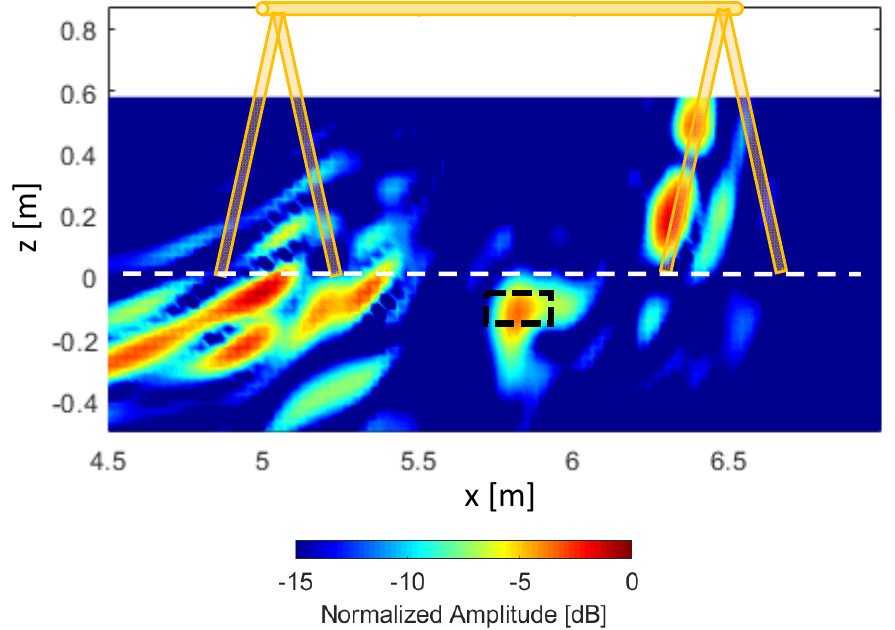
Figure 13. Imaging results for the buried plastic landmine. The position of the buried plastic landmine is highlighted with a black dashed line, and the average position in the z axis of the surface of the ground is depicted with a white dashed line. The profile of the 2D-measurement setup has been superimposed.